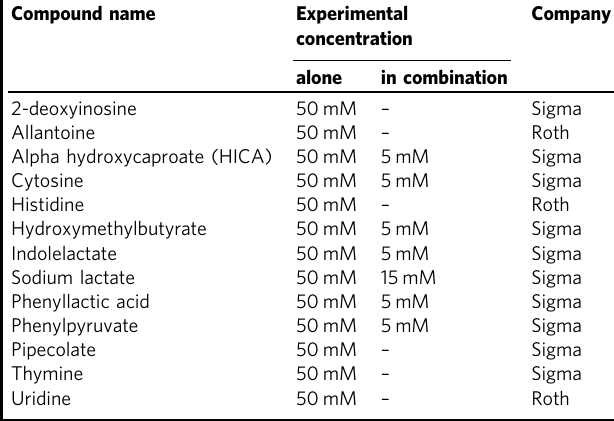
Table 2 Tested metabolites to impair C. albicans